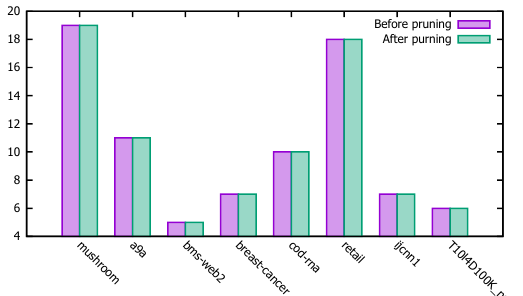
Figure 12. Impact of pruning operation on support count.